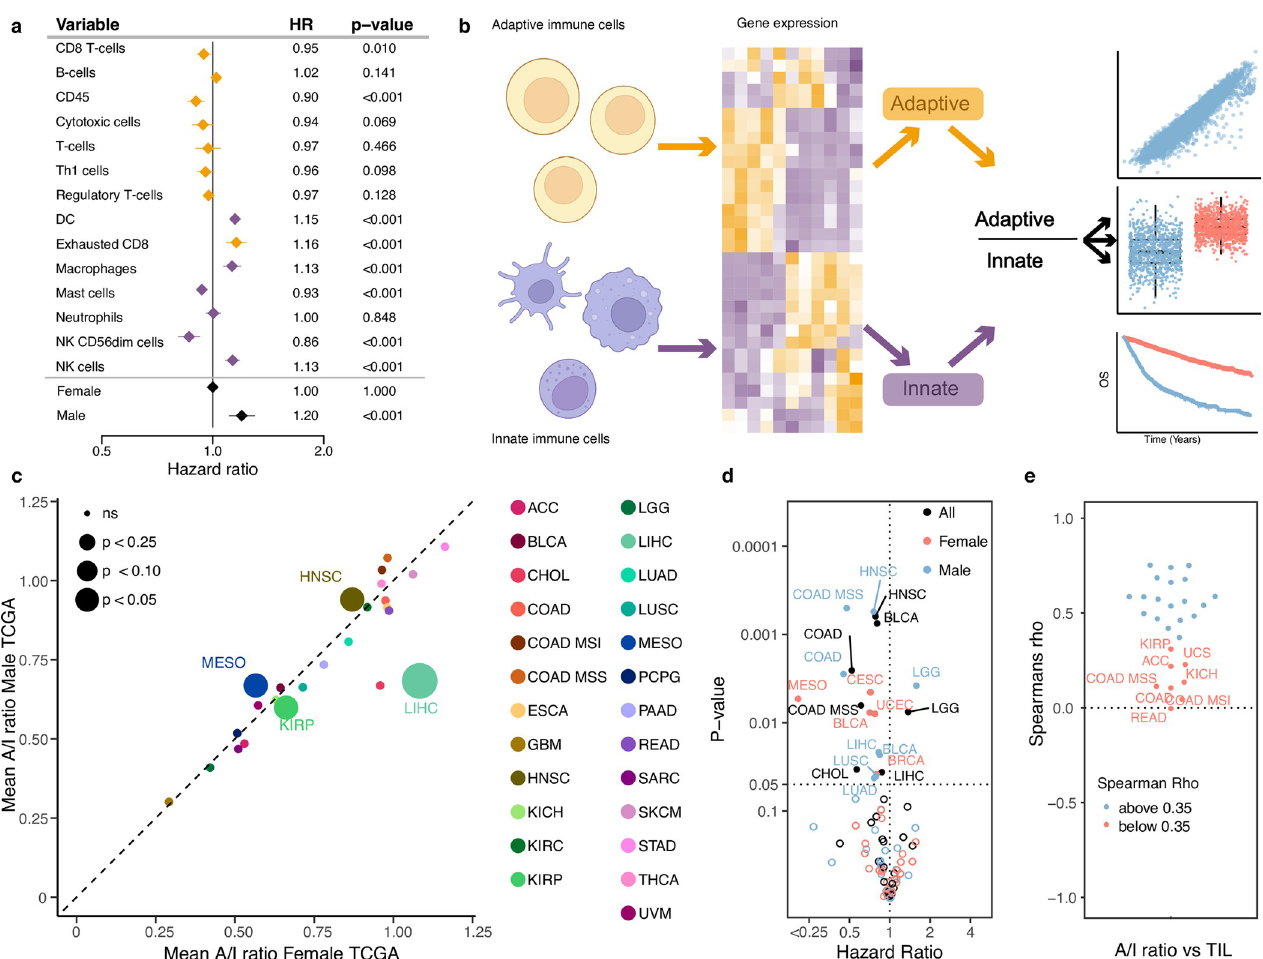
Fig 1. Calculating the adaptive/immune ratio. a) A forest plot showing the hazard ratio for progression of cancer for the expression of each of the cell types in the TIL calculation. Yellow marks adaptive immune cells, purple marks the innate immune cells. b) A schematic showing how we calculate the A/I ratio. c) The mean A/I ratio for 29 cancer types in the TCGA cohort. The female mean ratio on the x-axis and male ratio is in the y axis. The size of the dot represents the p- value for the comparison of the mean. d) Univariate cox proportional hazard regression for the A/I ratio against progression free interval (PFI) across cancer types and genders for TCGA. e) Correlation of the A/I ratio and the TIL score across all cancer types in TCGA.